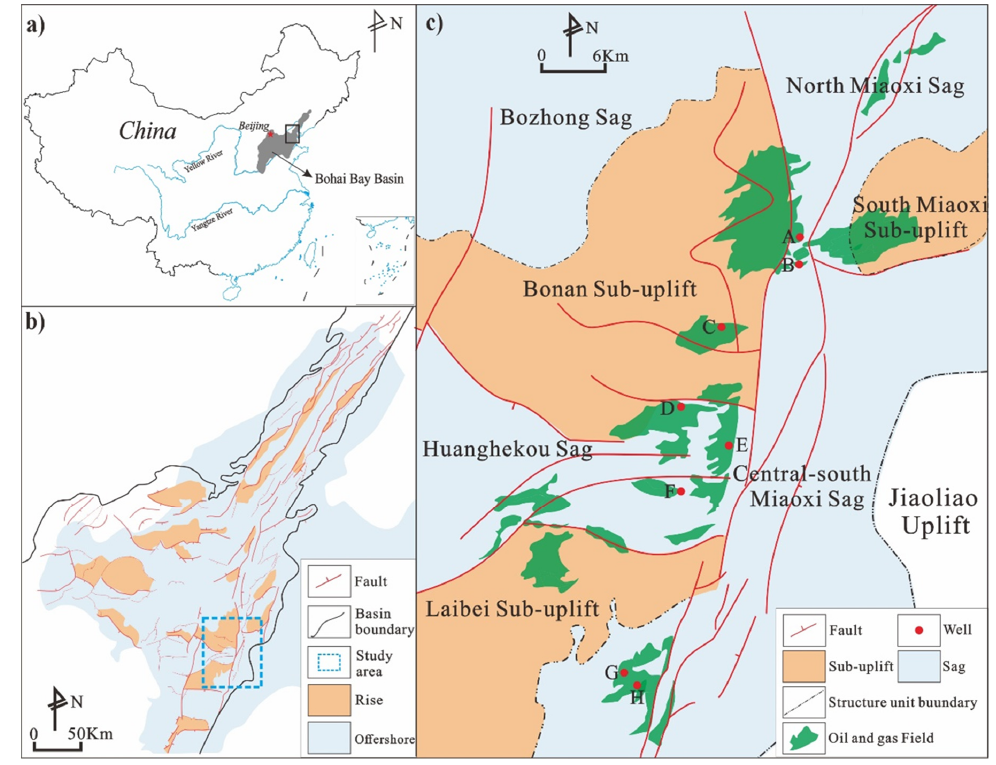
Figure 1. Maps showing the locations of the Bohai Bay Basin. ( a ) The study area ( b ) and the distribution of sampled well ( c ).